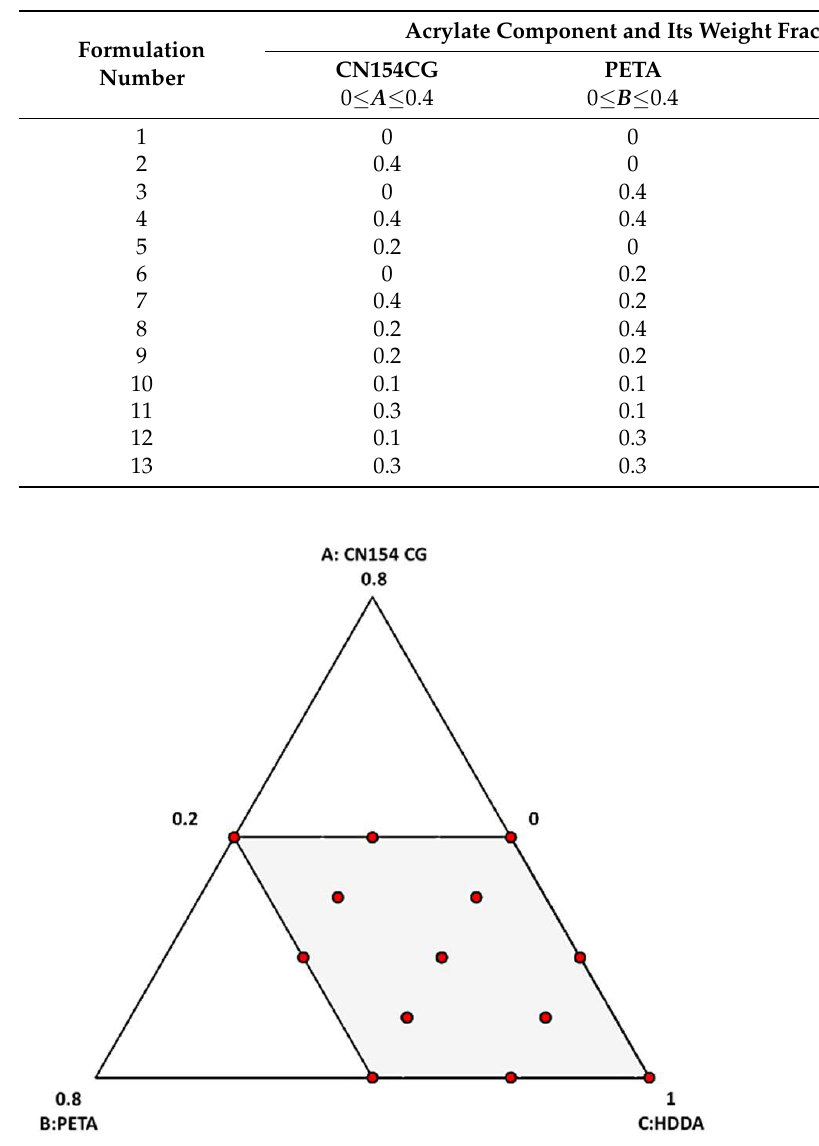
Table 2. Our uniform experimental design scheme for the preparation of resins.